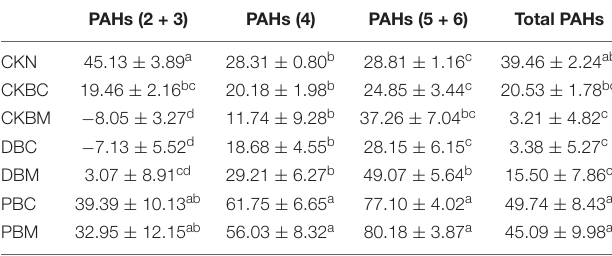
The number in the parentheses represents the rings of polycyclic aromatic hydrocarbons (PAHs). The degradation rate = (C 0 - C t )/C 0 × 100%, where C 0 is the initial PAH contents of different classifications (2 + 3 rings, 4 rings, 5 + 6 rings, and total PAHs; listed in Supplementary Table 4 ), and C t is the final PAH contents of different classifications on day 105 (listed in Table 1 ). Different letters mean significant differences, and the same letters mean no significant difference.